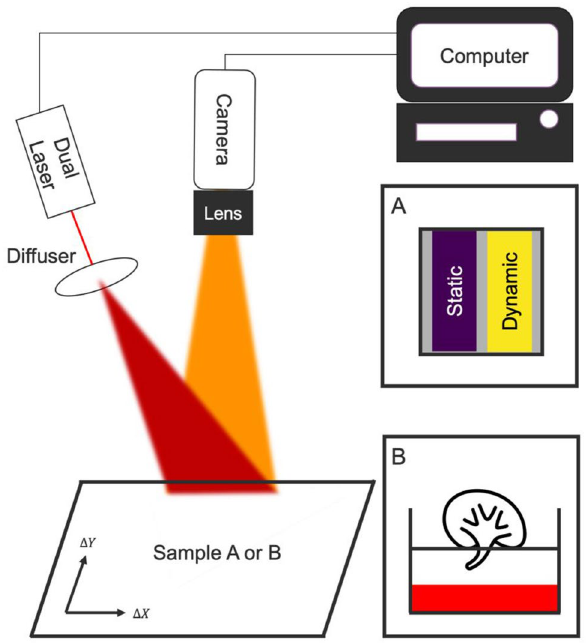
Figure 1. The dual-laser laser speckle contrast imaging (LSCI) setup with programmable 2D-movement artefact generator. The LSCI setup consisted of a color sensor, a computer and a dual-laser setup with a red 680 nm and green 532 nm 200mW laser. The samples a and b are placed on the 2D programmable motion platform. ( A ) The in vitro flow phantom presents one static- and one dynamic speckle region. ( B ) An ex vivo perfused porcine